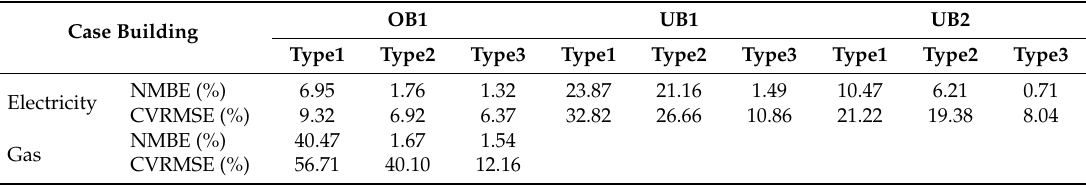
Table 10. Results of model